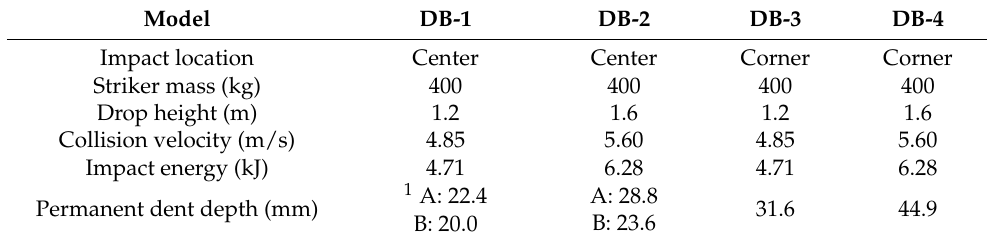
Table 3. Conditions of the collision tests: denting damage.